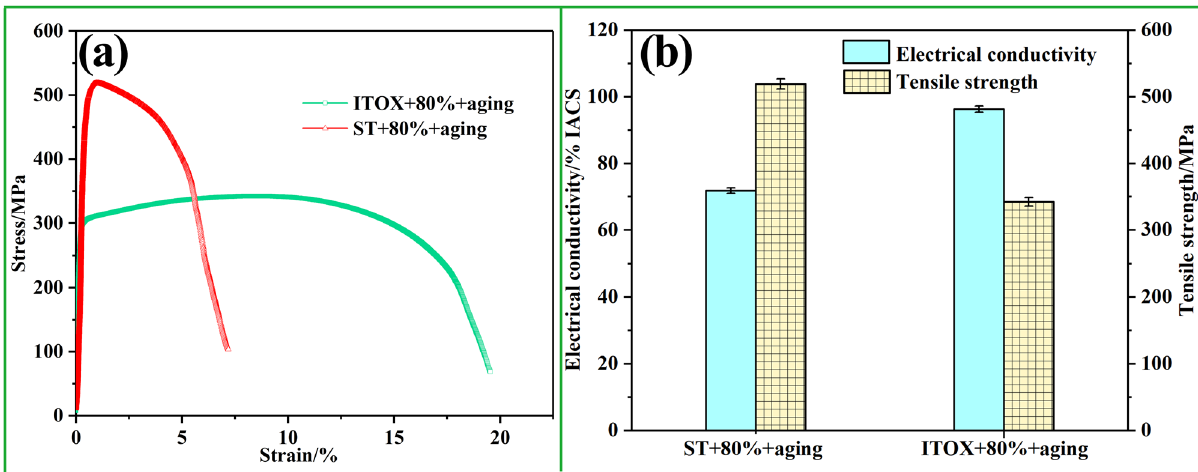
Figure 3: ( a ) Stress – strain curves and ( b ) electrical conductivity and tensile strength of Cu – Cr – Ti alloy after being treated by ST + 80% + aging and ITOX + 80% +